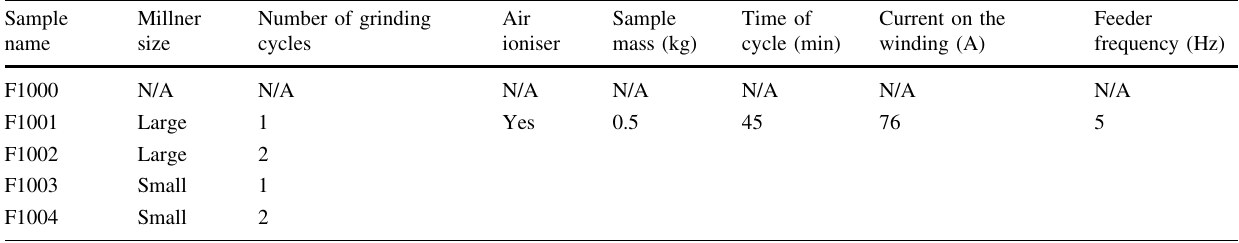
Table 1 Methodology of grinding process in electromagnetic